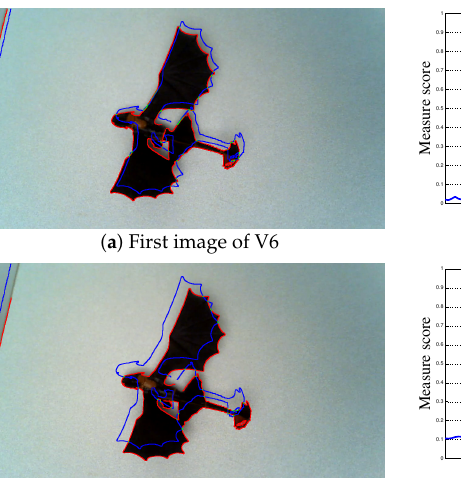
Figure 7. Localization metrics behaviors in a real experiment concerning video V5, 264 frames, with images of size 720 × 1280.